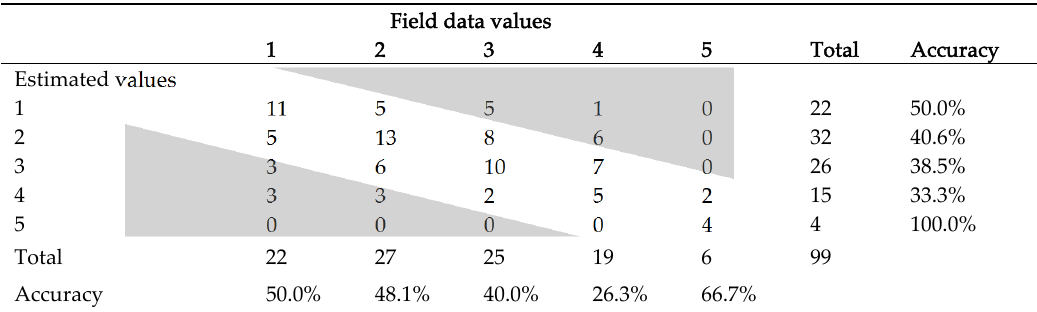
discriminant analysis (LDA).